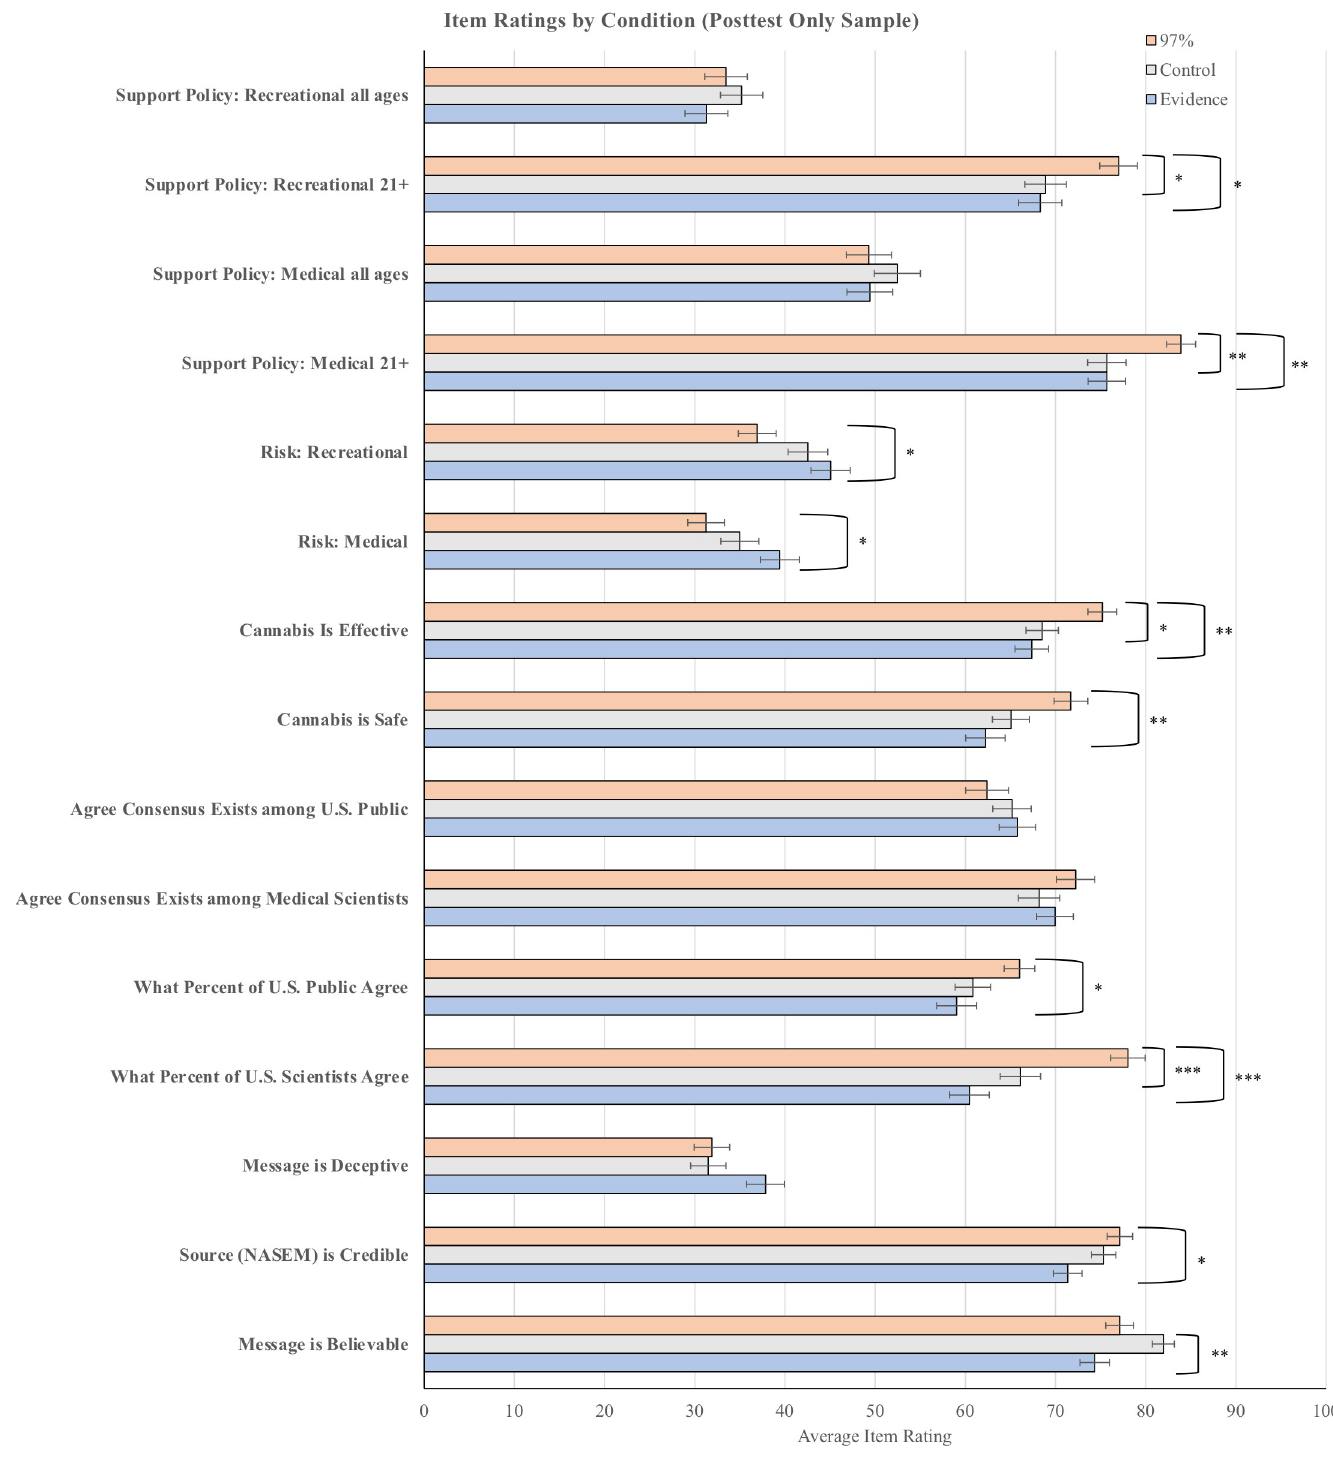
Fig 2. Mean rating for each item by condition and question for the posttest only sample. Error bars represent standard error. Significant differences between message conditions (determined by Tukey tests) are shown. ��� p < .001, �� p < .01, � p < .05.